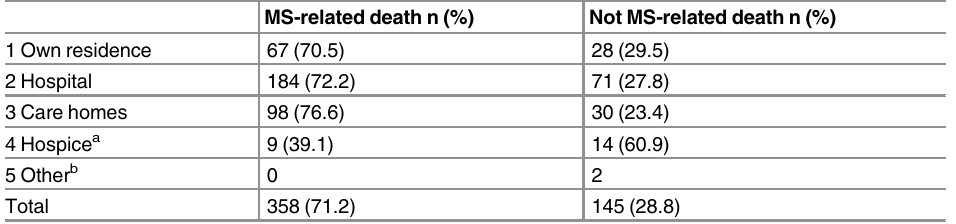
Table 4. The relationship between place of death and whether a death was